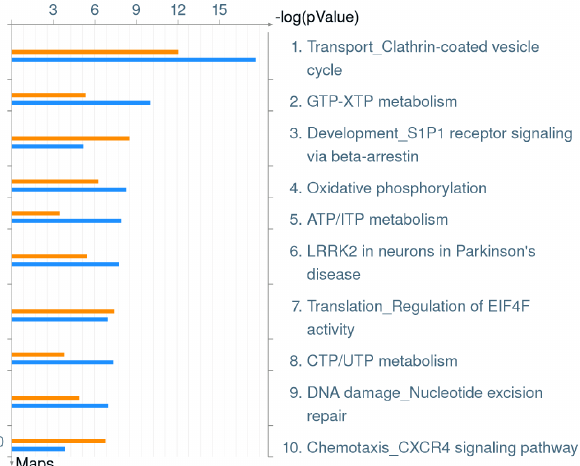
Figure 3. Top 10 Pathway Maps down-regulated in hMDMs upon infection by L. pneumophila . Meta- ankB mutant-infected hMDMs at 8 h post-infe- hMDMs while the lower blue bar represents the ankB mutant-infected